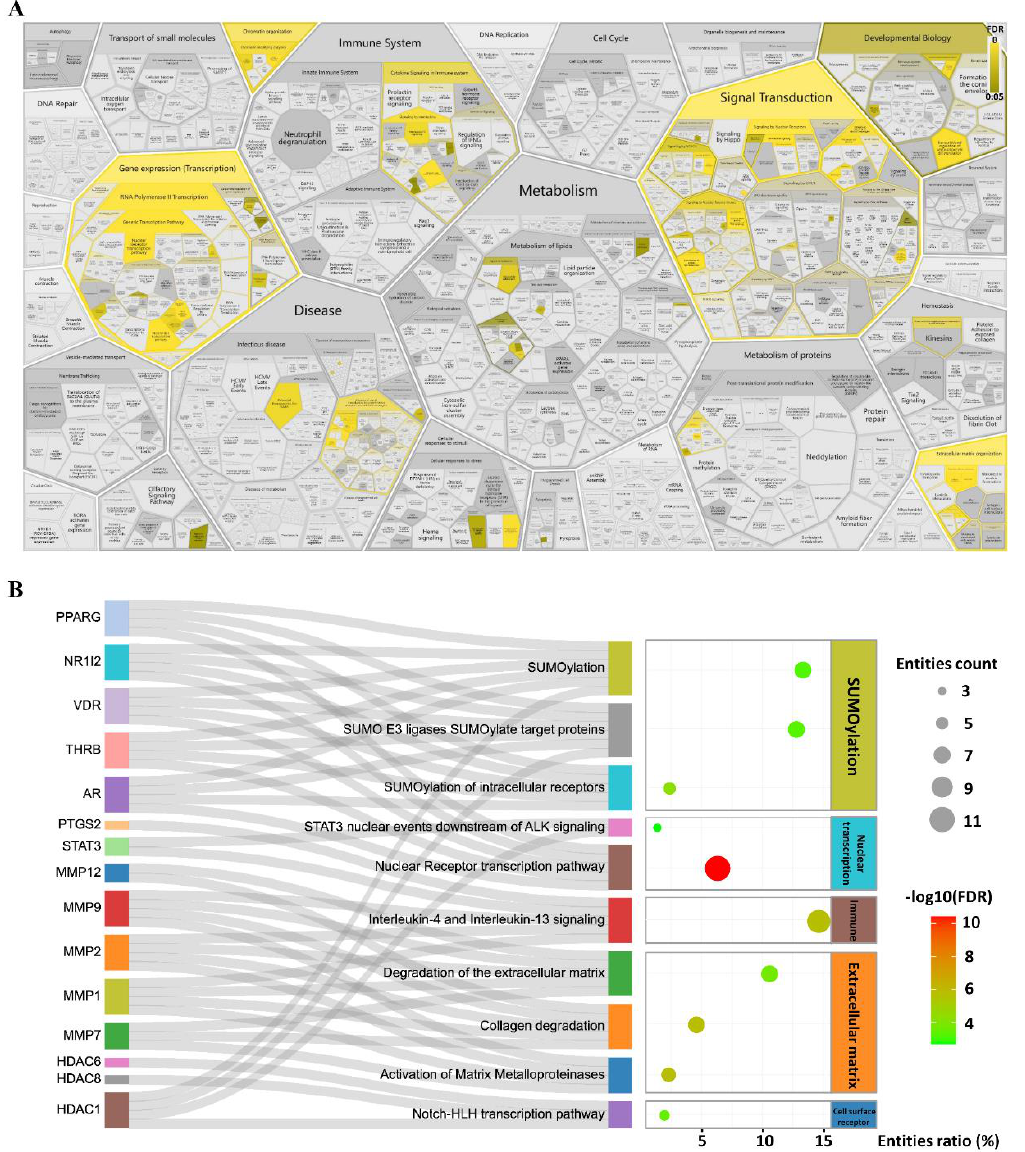
Figure 3. REACTOME enrichment results. ( A ) Overall map of enrichment results. ( B ) Top 10 signalling pathways based on increasing FDR and the genes involved in these pathways. The 40 candidate genes were used for REACTOME enrichment analysis at https://reactome.org (version 79, accessed on 13 March 2022).